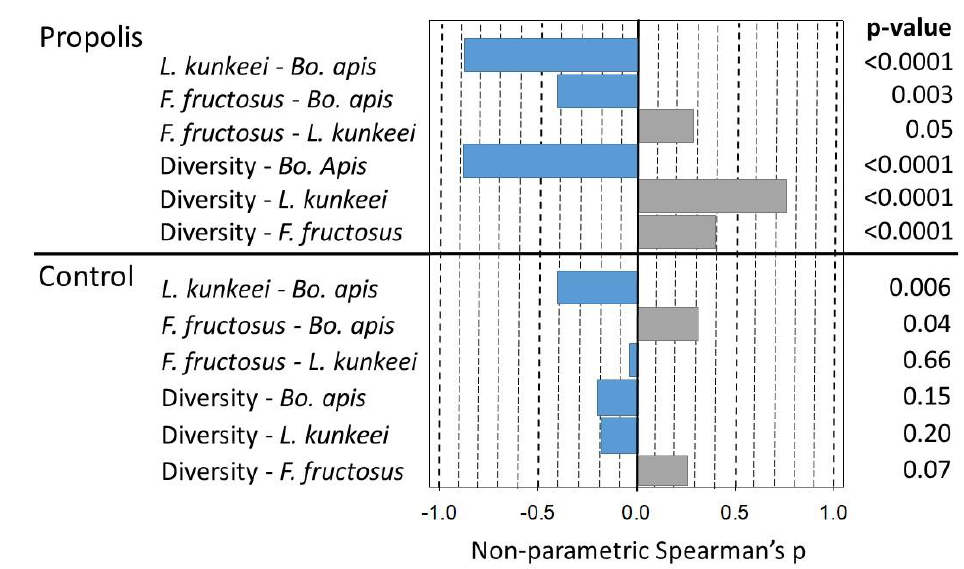
Figure 3. Spearman’s correlations comparing treatments, the absolute abundance of operational taxonomic units (OTUs), and the microbiome diversity. Treatments are propolis and the control (no propolis). The pairwise species correlations depict a positive (gray) or negative (blue) association between the absolute abundance of each species. The mouthpart microbiome diversity is calculated as inverse Simpson’s, which increases with numerical values. Therefore, positive correlations between species and diversity (in gray) depict a greater absolute abundance of species associated with an increased mouthpart diversity. Negative correlations (in blue) depict a lower species absolute abundance associated with an increased mouthpart diversity.